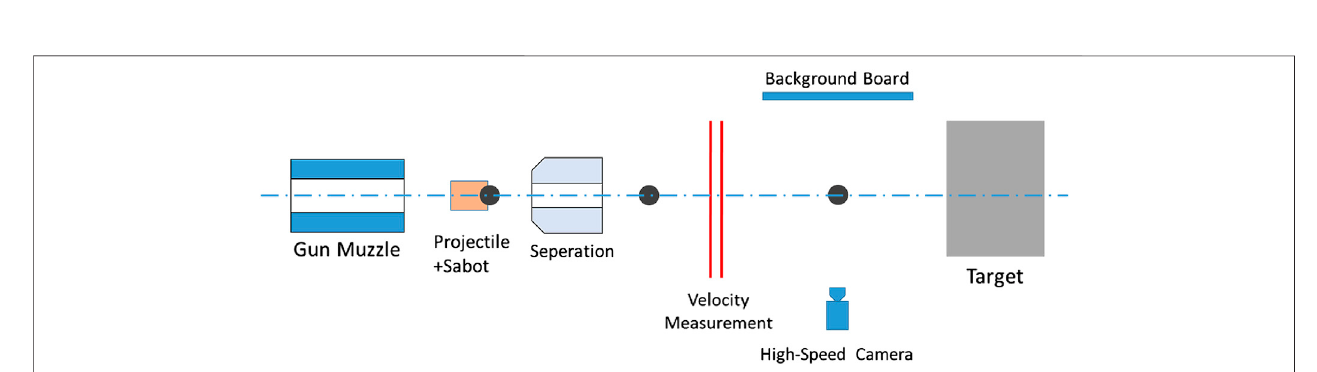
FIGURE 1 | Sketch of the experiment setup.